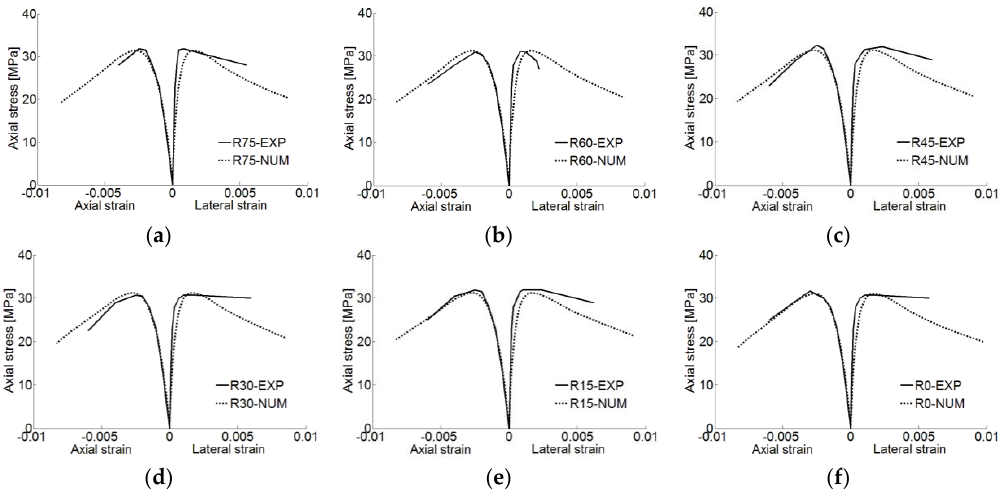
Figure 6. Plain concrete: uniaxial stress-strain curves: ( a ) R75, ( b ) R60, ( c ) R45, ( d ) R30, ( e ) R15, ( f ) R0.